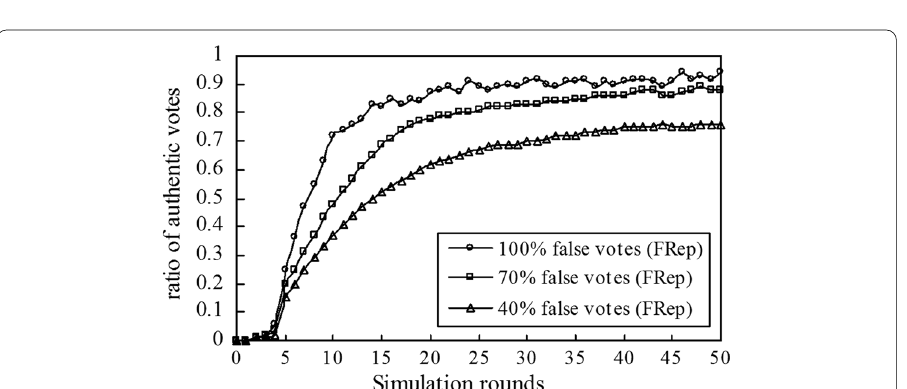
Fig. 7 Simulation result of system with tricky deceivers. Figure shows the ability of FRep to resist tricky deception obtained by experiments under the environment of 30% malicious nodes, in which the proportion of false evaluation provided by malicious nodes is 40%, 70% and 100%,